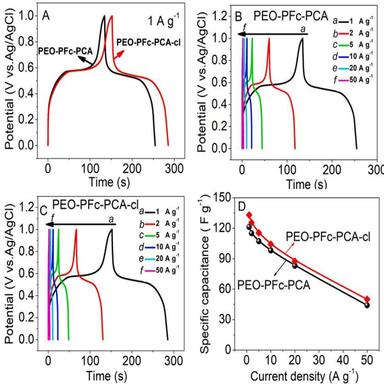
(A) Constant current charge-discharge comparison of PEO-PFc-PCA before and after photo-crosslinking at a current density of 1 A g-1; (B) and (C) show the constant current charge-discharge curves of PEO-PFc-PCA before and after photo-crosslinking at various current densities; (D) Variation of specific capacitance of PEO-PFc-PCA before and after photo-crosslinking as a function of current density.